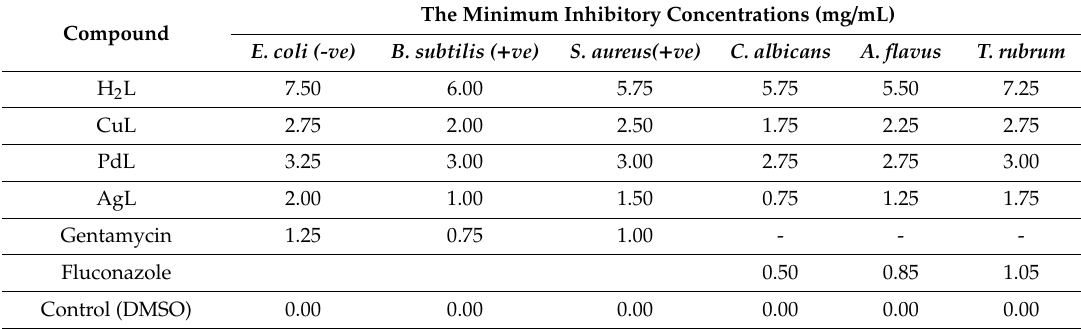
Table 7. The minimum inhibitory concentration values of the new H 2 L ligand and its CuL, PdL and AgL complexes against the selected strains of bacteria and fungi.